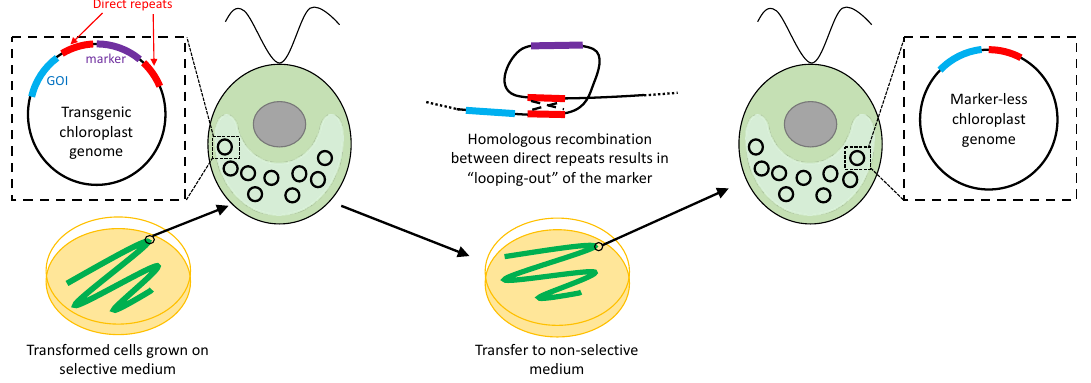
Figure 6. Marker removal based on direct repeats. Once the selective pressure to keep the selectable marker is removed, homologous recombination occurs between repeats flanking the marker, resulting in loss of the marker from the chloroplast genome [94].